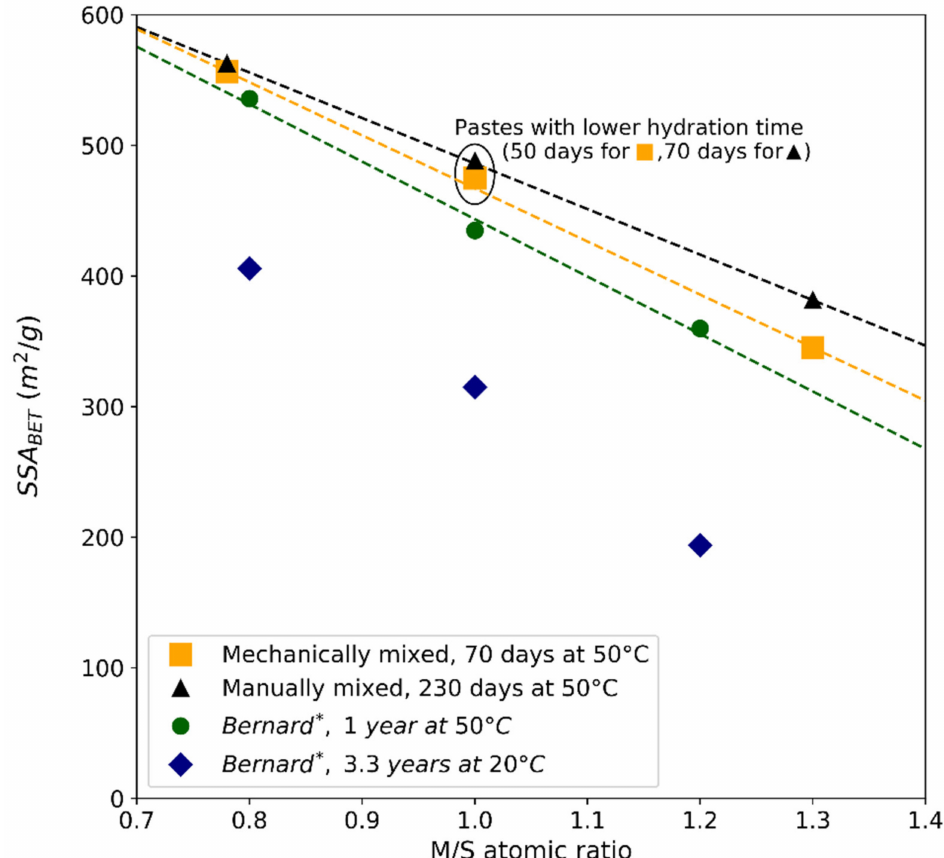
Figure 13. Specific surface area (SSA BET ) found in M-S-H pastes as a function of the M/S atomic ratio and of the mixing protocol. The dotted lines are the trend lines from the mechanically mixed (orange), manually mixed (black) and * Bernard et al. [43] measurements (green: M-S-H powders equilibrated for 1 year at 50 ◦ C; blue: M-S-H powders equilibrated for 3.3 years at 20 ◦